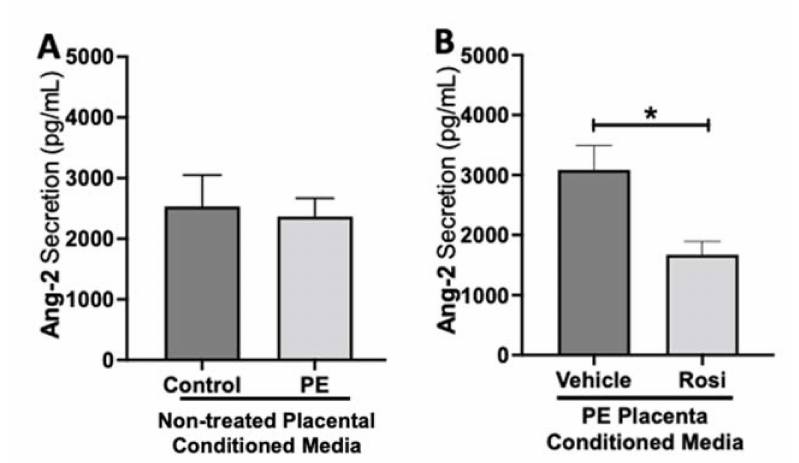
Figure 1. Angiopoeitin-2 secretion is reduced in Rosiglitazone-treated preeclamptic placentas. Angiopoeitin-2 (Ang-2) levels were measured via Luminex assay from conditioned media from non-treated control and preeclamptic (PE) placentas ( A ) and vehicle- or Rosiglitazone (Rosi)-treated PE placentas ( B ). There was no significant difference in Ang-2 secretion between PE and control placentas ( A , n > 10). Rosi-treated PE placentas show a significant reduction of Ang-2 secretion in comparison to the vehicle control ( B , n = 14). (Protein secretion was measured by a Luminex assay where experimental values were determined relative to a standard curve. Statistical analysis was performed by student’s t -test to determine significant differences between groups, * p < 0.05, bar plots and data reported are reported as mean pg/mL values ± SEM).